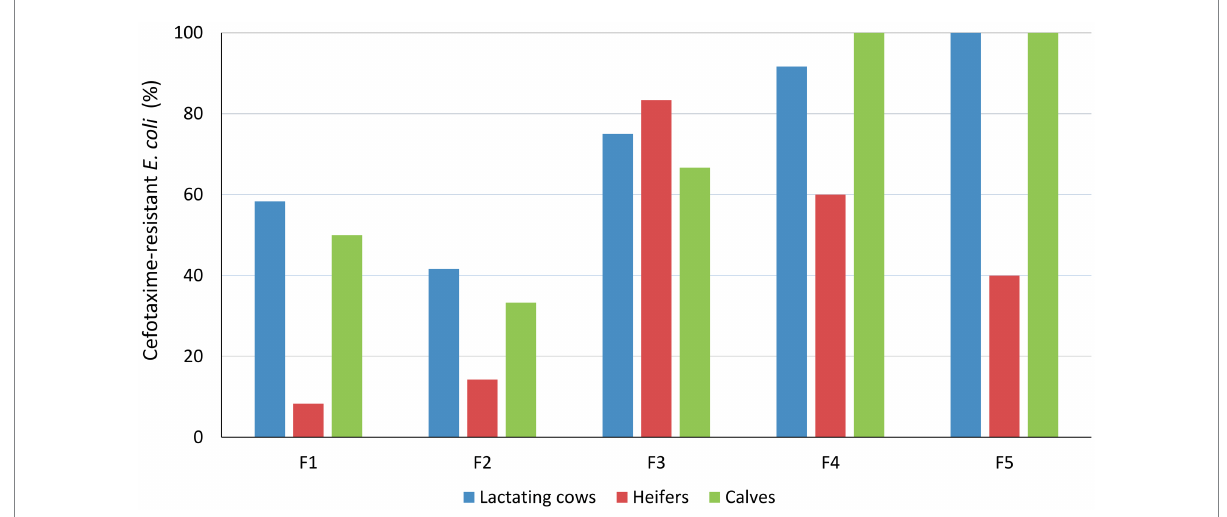
FIGURE 1 Isolation frequency of cefotaxime-resistant E. coli among age groups and farms. Results were based on 12 samplings per farm and age group, except for heifers in F2 and F4 where only 7 and 10 pool samples were collected, respectively, and F5, which dropped out from the study after 5 samplings due to operational